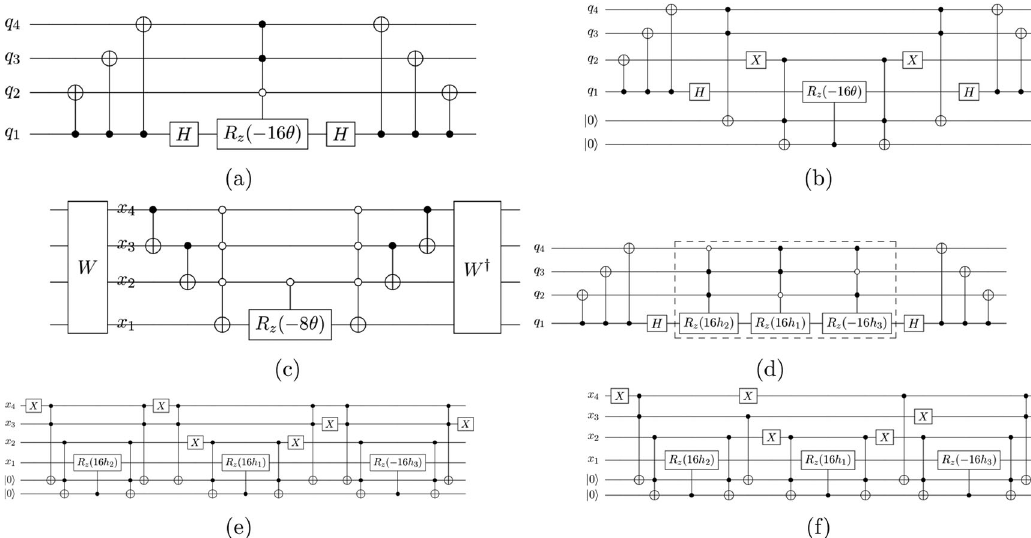
Fig. 1 Quantum circuit simulating e − iHt . a Circuit when a 1 t = a 6 t = − θ and a 0 t = a 2 t = … = a 5 t = a 7 t = θ . (b) Circuit in a with the multi- controlled rotation implemented with Toffoli and controlled rotation. c Circuit when a 0 t = … = a 7 t = θ . d Circuit when the coef fi cients are as in Equation 18. e Circuit in d with the multi-controlled rotations in the boxed section implemented with Toffolis and controlled rotations. f Circuit in e with some further reduction of the intermediate Toffoli